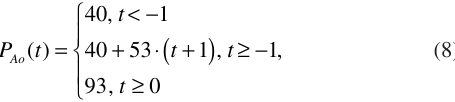
Figure 2. Baroreflex model. A . The response of the baroreflex model to a step increase in pressure is compared to data from Chapleau et al . 13 . The model simulations are based on Equation (4)–Equation (7), as described in the text. B . Simulated baroreflex output based on input aortic pressure wave obtained from Coleridge et al. 11 Figure 2B plots model-predicted baroreflex firing rate elicited by the normal aortic pressure waveform of Coleridge et al. 12 . The model produces the characteristic bursting pattern where peaks in baroreceptor afferent firing occur in systole, with the firing rate dropping to zero in diastole.